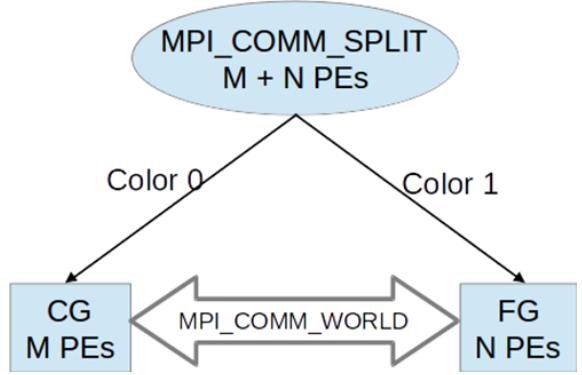
Figure 3. Schematic of the MPI processor grouping. The data ex- change between the two groups is performed via the global com- municator. M and N are the number of processors for CG and FG